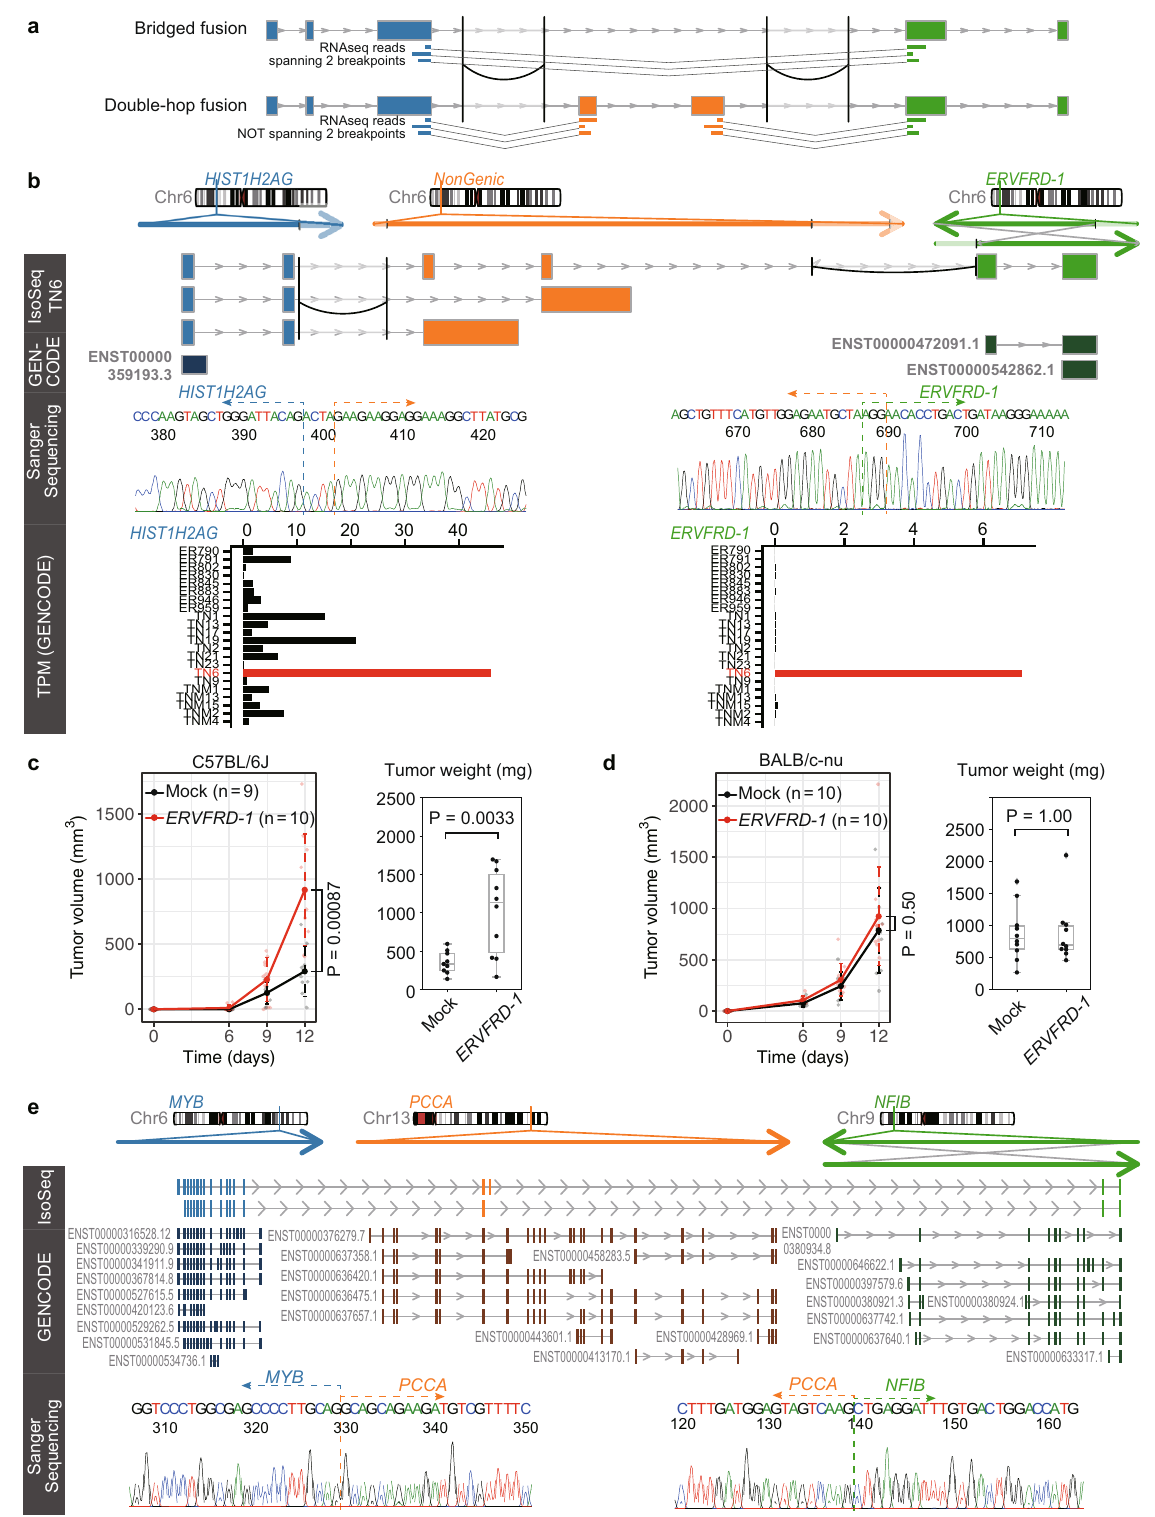
Fig. 6 Double-hop fusion. a Schematic image of difference between bridged fusion transcript and double-hop fusion transcript. b Structure of double-hop fusion transcripts from HIST1H2AG – NonGenic – ERVFRD-1 . The genomic axes represent three original genomic regions; below them are chimeric IsoSeq cluster reads. Curves correspond to structural variants detected with whole-genome sequencing data. The category “ GENCODE ” shows annotated transcripts. Outside regions of structural variants are shaded. To ensure visibility, exon – intron structures do not necessarily re fl ect accurate length. TPM denotes transcript per million. c , d Growth of MC38 tumor cells expressing ERVFRD-1 in C57BL/6J mice ( c ) and in BALBc/nu-nu mice ( d ). Error bars represent standard error. e Structure of double-hop fusion transcripts from MYB – PCCA – NFIB . Representative transcripts are shown for the GENCODE